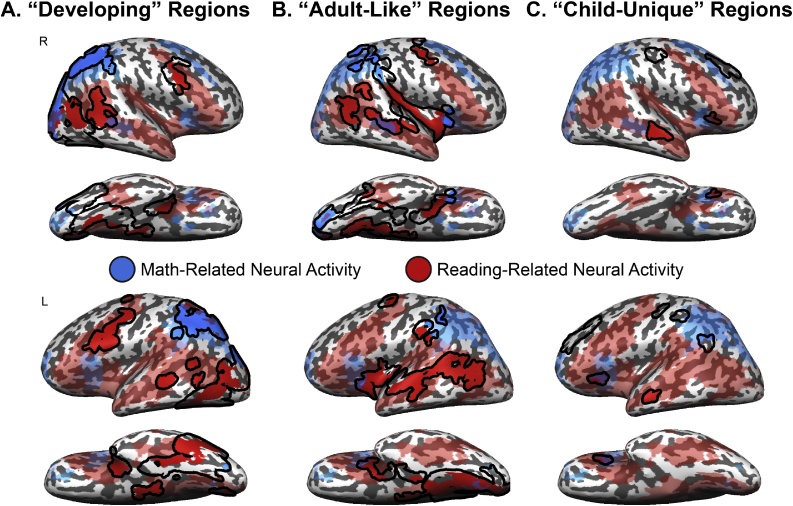
Conjunction of the functional networks for reading vs math fromFig. 2C and the 3 patterns of neural similarity fromFig. 1. All regions classified as Developing, Adult-like, or “Child-Unique” are outlined. The conjunction is shown by the colors within the outlined regions. The full mathematics (blue) and reading (red) networks from Fig. 2C are overlaid for visualization purposes (For interpretation of the references to colour in this figure legend, the reader is referred to the web version of this article.).